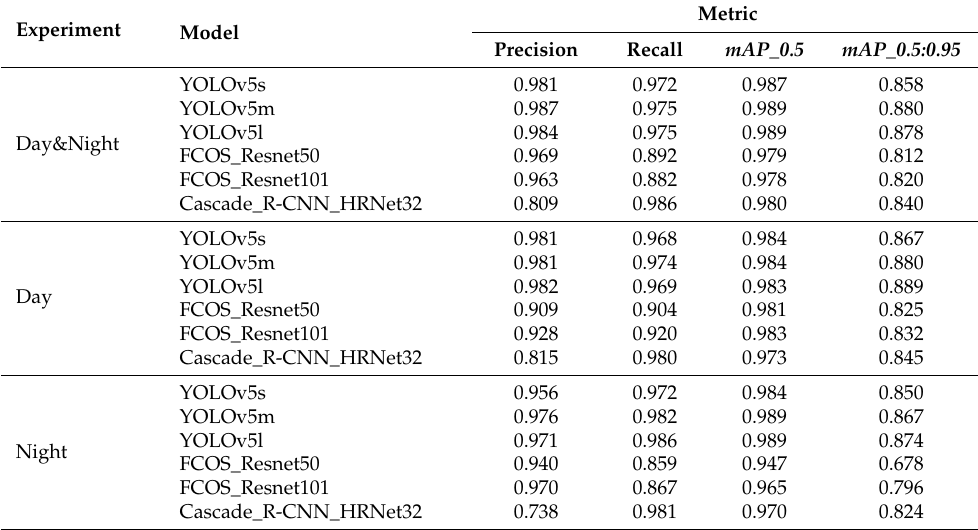
Table 4. Overall recognition accuracy of different object detection